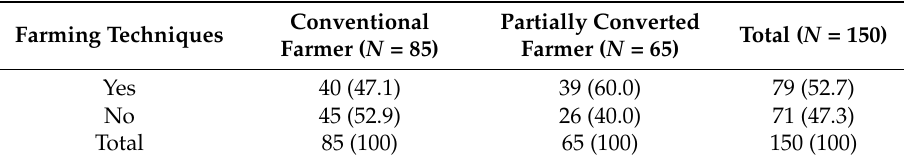
The response of upstream farmers for willingness to convert farming method to Environmentally Friendly Farming